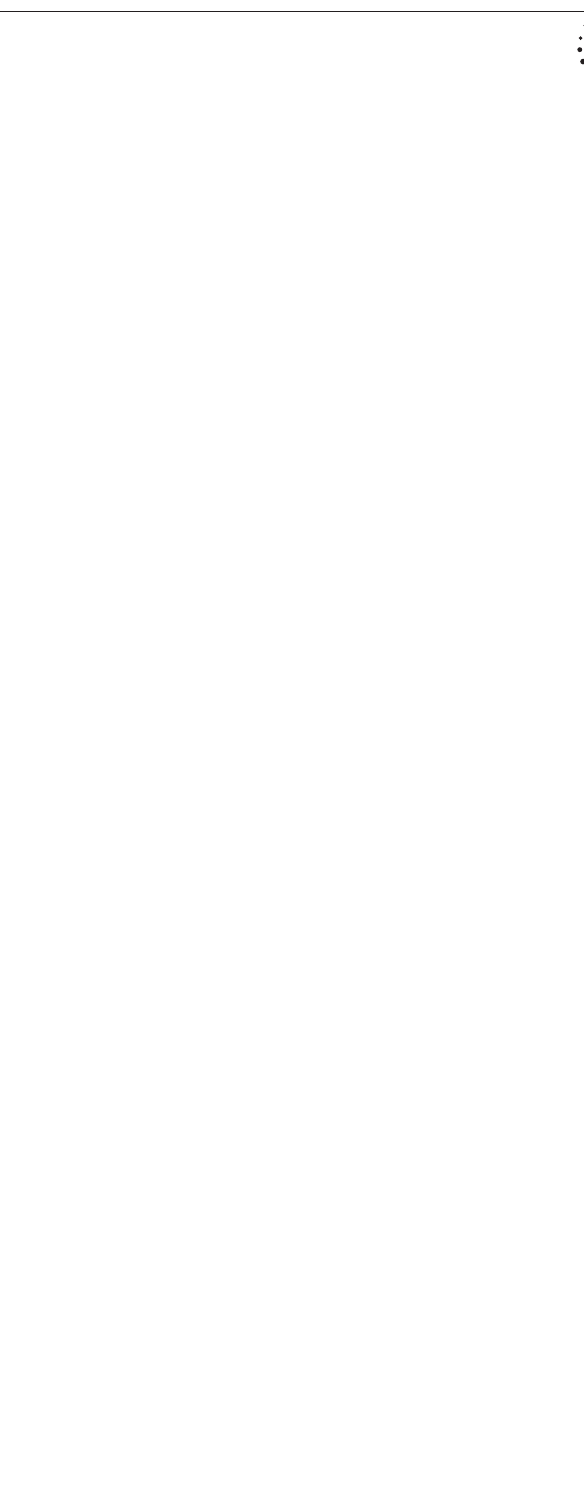
4 South African Journal of Science